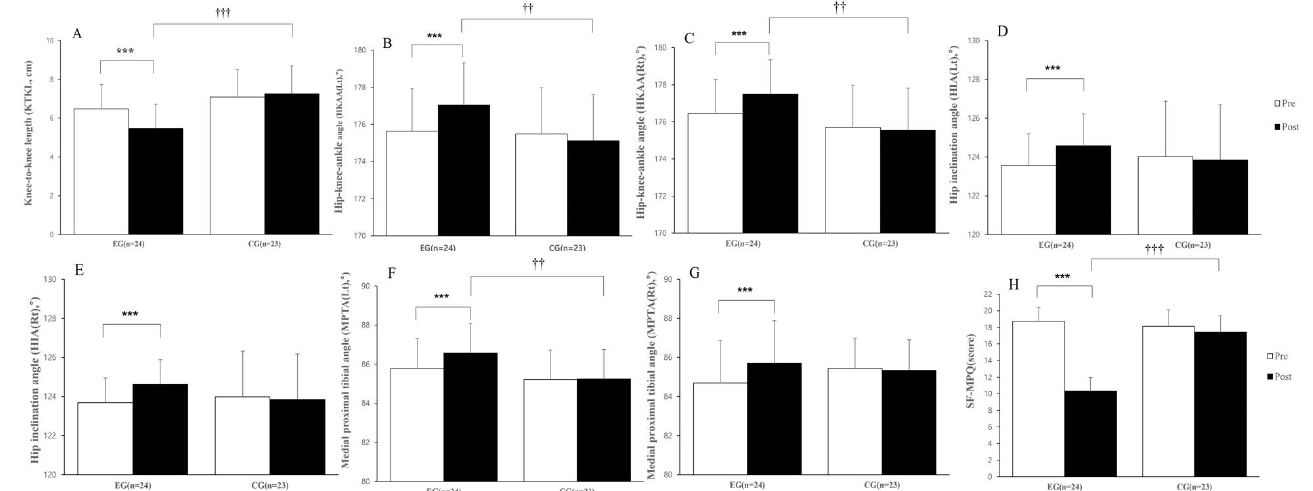
Figure 3. Values are presented as the mean ± standard deviation: ( A ) knee-to-knee length (KTKL); ( B ) hip–knee–ankle angle ( Left ); ( C ) hip–knee–ankle angle ( Right ); ( D ) hip inclination angle ( Left ); ( E ) hip inclination angle ( Right ); ( F ) medial proximal tibial angle ( Left ); ( G ) medial proximal tibial angle ( Right ); ( H ) short form-McGill Pain Questionnaire (SF-MPQ). Significant differences using paired t -test: *** p < 0.001. Significant differences using independent t -test: †† p < 0.01, ††† p <